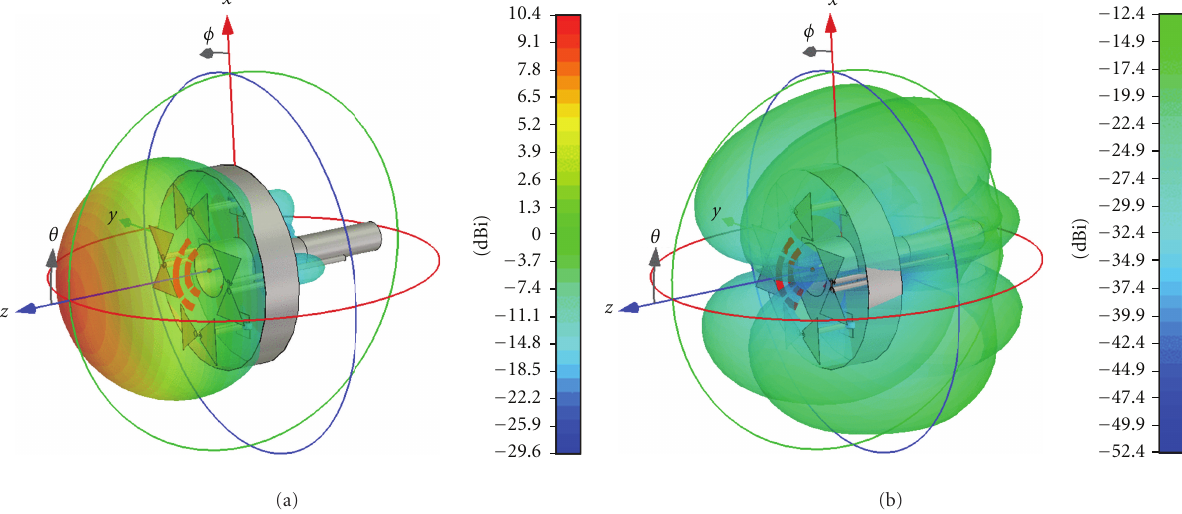
Figure 6: 3D radiation pattern at 432 MHz; copolarization (a) and cross-polarization